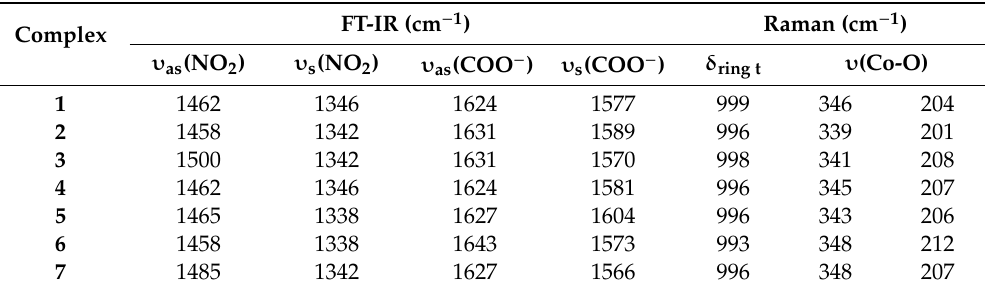
Figure 3. Comparison of absorption spectra in the infrared region of complexes 2 – 7 . Table 2. Infrared and Raman spectral bands of 1 – 7 . υ : stretching; s : symmetric; as : asymmetric; δ : flexion; t : tri-substituted.